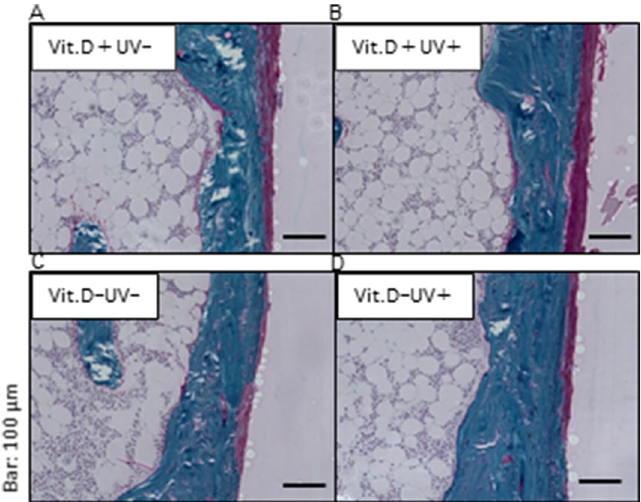
Figure 11. Villanueva Goldner staining. Stained coronal sections were presented of the medial metaphysis of right femurs at 48 weeks of age (original magnification × 200, bars indicate 100 μm). ( A ) Vit.D+ UV− group.